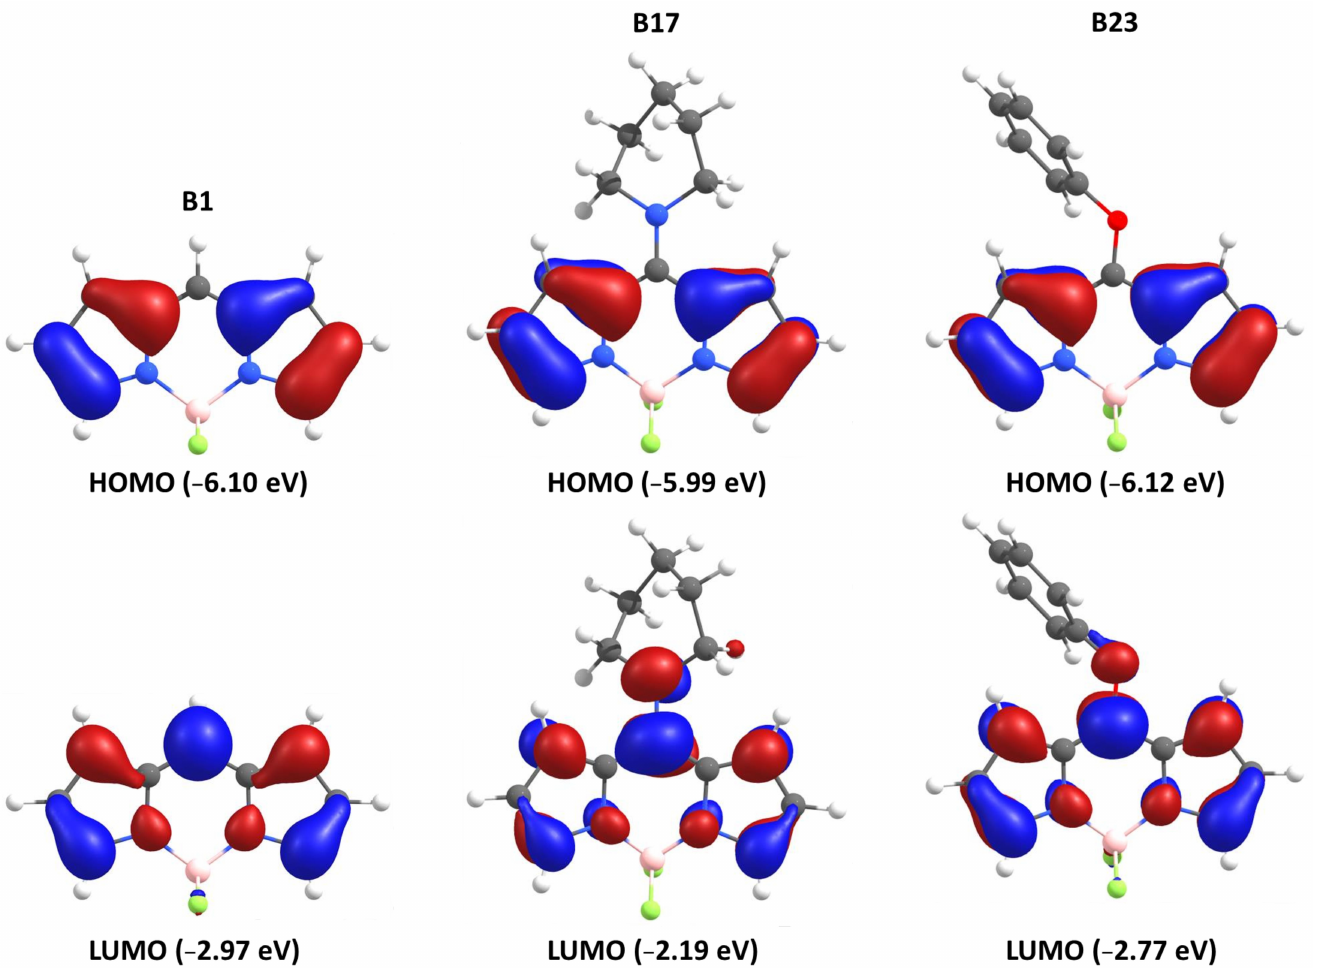
Figure 2. Comparison of the HOMO and LUMO contours for three selected investigated